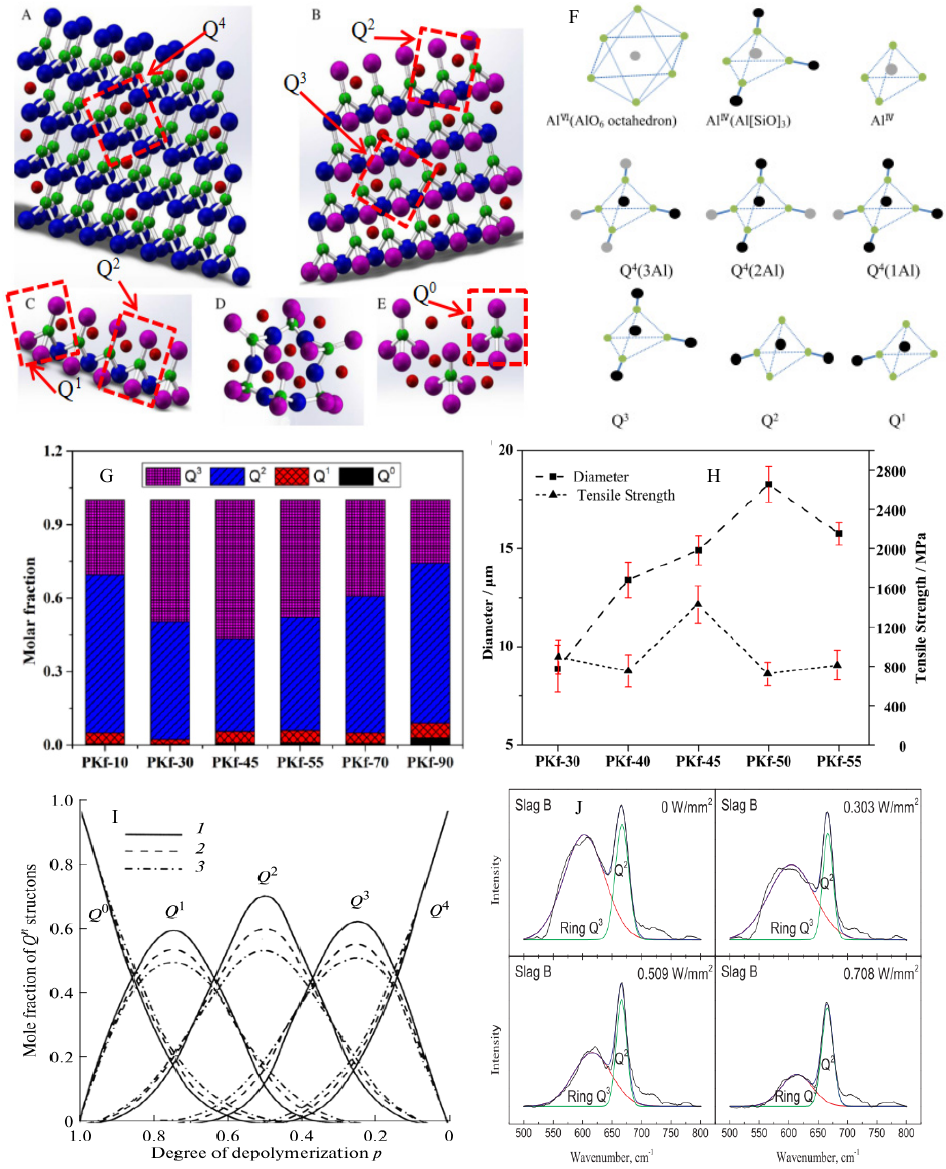
Figure 4. The structures of the continuous fibers. ( A ‒ E ) (Xing et al., 2019) Five types of structure of the fibers. ( F ) Structure units in continuous fibers with high thermal stability (Zhang et al., 2020). ( G ) The structural composition of the fibers varies with its composition (Liu et al., 2021). ( H ) The diameter and tensile strength of the fibers varies with its composition (Liu et al., 2021). ( I ) The structural composition of melt varies with the degree of depolymerization (Polyakow et al., 2010). ( J ) Raman spectra of fluorine-bearing slag melt under ultrasound field (Min et al.,